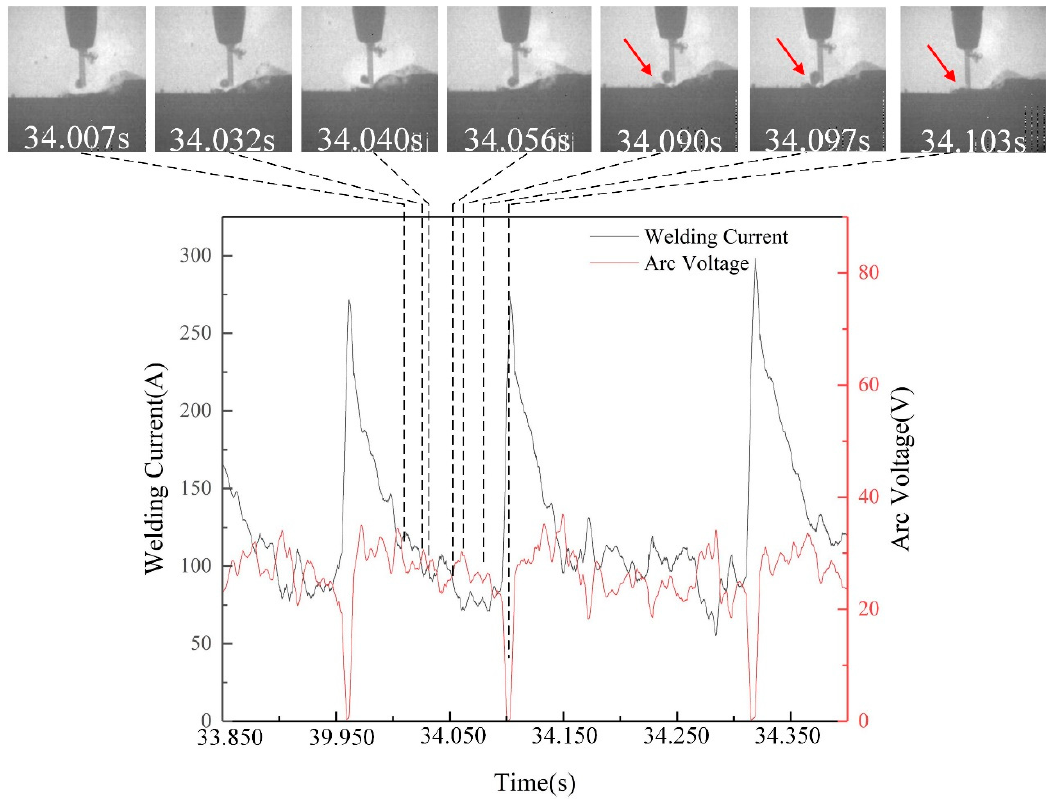
Figure 7. Typical surface tension transfer mode and electric signal (28% filling rate).